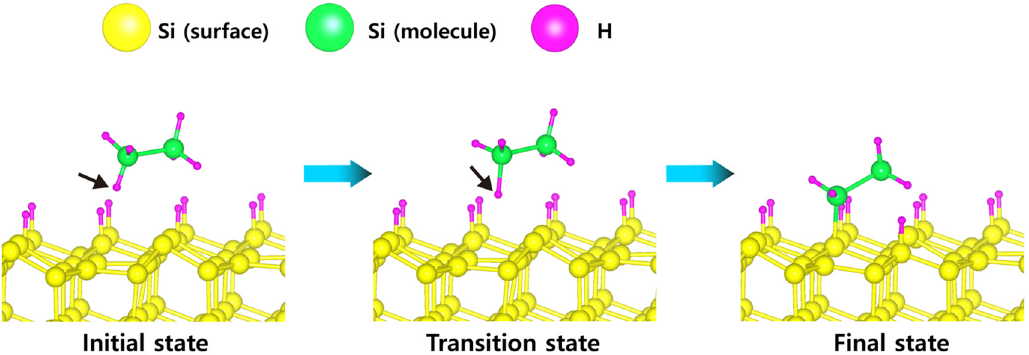
Figure 8. Optimized initial, transition and final structures for the first dissociative reaction step of a Si 2 H 6 molecule on the H-50% covered Si(111) surface.